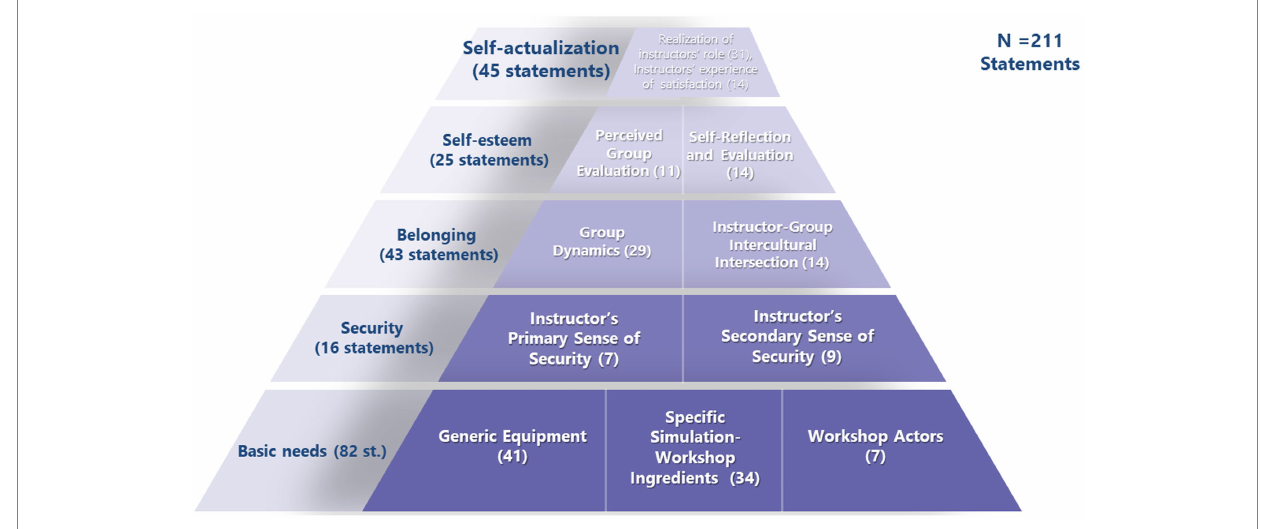
FIGURE 2 Instructors’ needs according to the MHN. Frequencies of instructors’ need-related statements arranged according to the MHN levels. In parentheses: number of statements per theme; on the left: number of need-statements per MHN level and their percentage of the total number of need-statements at all